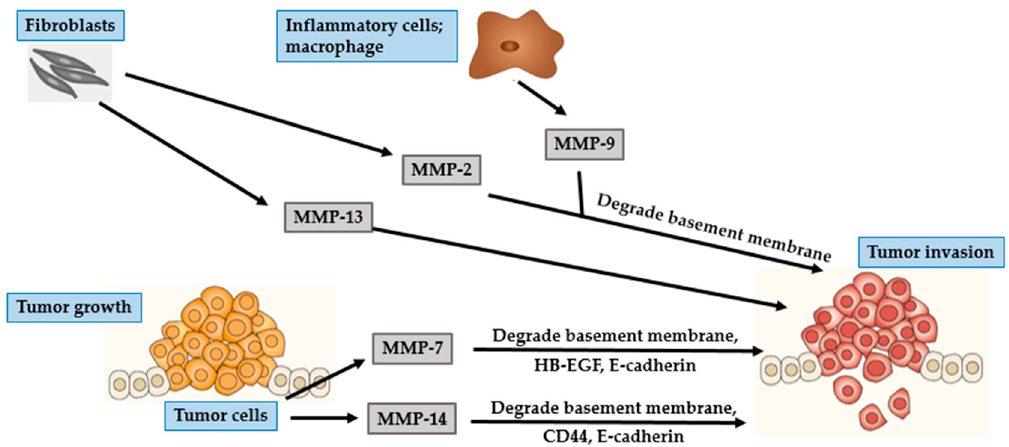
Figure 3. Role of MMPs in BCC tumor invasion. MMP-2 and MMP-13 secreted by fibroblasts facilitate tumor invasion. Inflammatory cells-derived MMP-9 degrades the basement membrane and promotes tumor invasion. BCC cells secrete MMP-7 and MMP-14. MMP-7 degrades the basement membrane, HB-EGF and E-cadherin, whereas, MMP-14 degrades the basement membrane, CD-44 and E-cadherin. Together, they play an important role in tumor invasion.